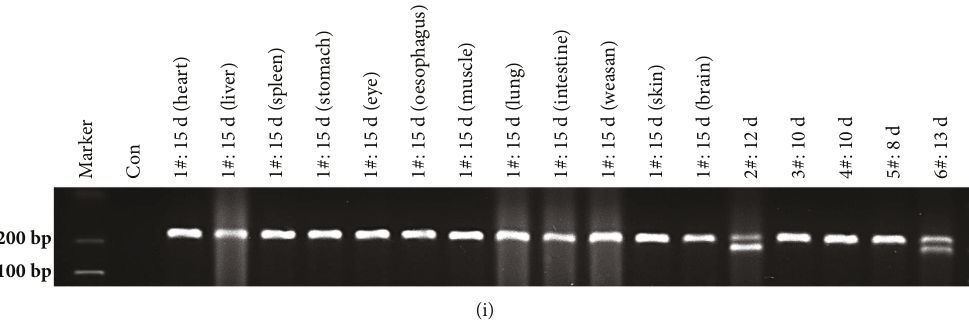
Figure 5: In vitro and in vivo di ff erentiation of cultured cESCs. (a) Embryoid body-like structures in the phase after the cESCs were cultured without the growth factors for 10 days. (b) Oil Red O positive staining showed the di ff erentiation to adipocytes in the phase. cESCs with complete culture medium in the phase were the control. (c) The expression of PPAR γ (red) con fi rmed the di ff erentiation to adipocytes, and the nucleus was stained by DAPI (blue). (d) Alizarin Red staining veri fi ed the potentiality to osteoblasts. cESCs with complete culture medium in the phase were the control. (e) The immuno fl uroscence of desmin (red) and DAPI (blue) certi fi ed the directional di ff erentiation to smooth muscle cells. (f) MHC (red) and DAPI (blue) staining proved di ff erentiation to cardiac myocytes. (g) The immuno fl uorescence of PAX6 (green) and DAPI (blue) showed the di ff erentiation to neural cells. (h) The process of chimeric chicken production was indicated in the fi gure. Chimeric chickens generated after grafting cultured cESCs of 25 passages in vitro . (i) The two distinct genotypes of PRLpro2 on the gel picture veri fi ed that there were two successful productions of chimeric embryos. PCR analysis of PRLpro2 genotype. Six chicken embryos after 15 d, 12 d, 10d, 8 d, and 13d incubation were tested. Scale bar: 100 μ